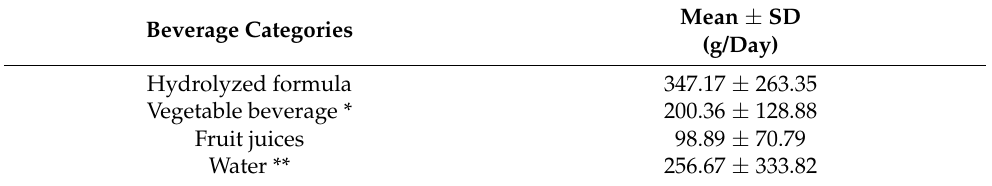
Table 4. The Pearson correlation coefficient between Nutrilog© and Nutricate© were highly significant ( p = 0.0001), and they were well-correlated (R coefficient > 0.6), indicating a very good concordance between the two methods (Table 5). This observation was reinforced by the Bland–Altman plot, indicating the absence of proportional or fixed bias for energy, protein, calcium, and iron intakes. The relative mean differences between Nutricate© and Nutrilog© were all <10%, with − 1.7% for energy intake, +9.5% for protein intake, +9.6% for calcium intake, and − 2.4% for iron intake, indicating a very good agreement between the two methods. Table 3. Means of beverage intakes per day, according to the categories (n = 30). Beverage Categories